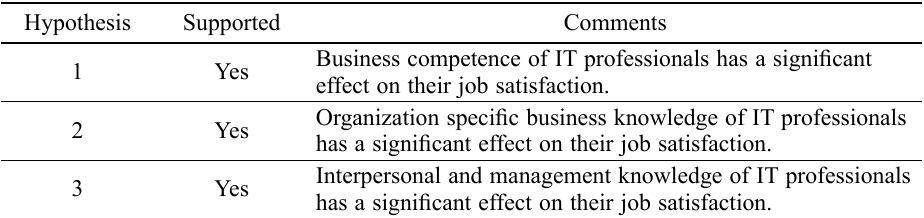
Fig. 2. Business competence and its effect on job Table 8. Overview of results